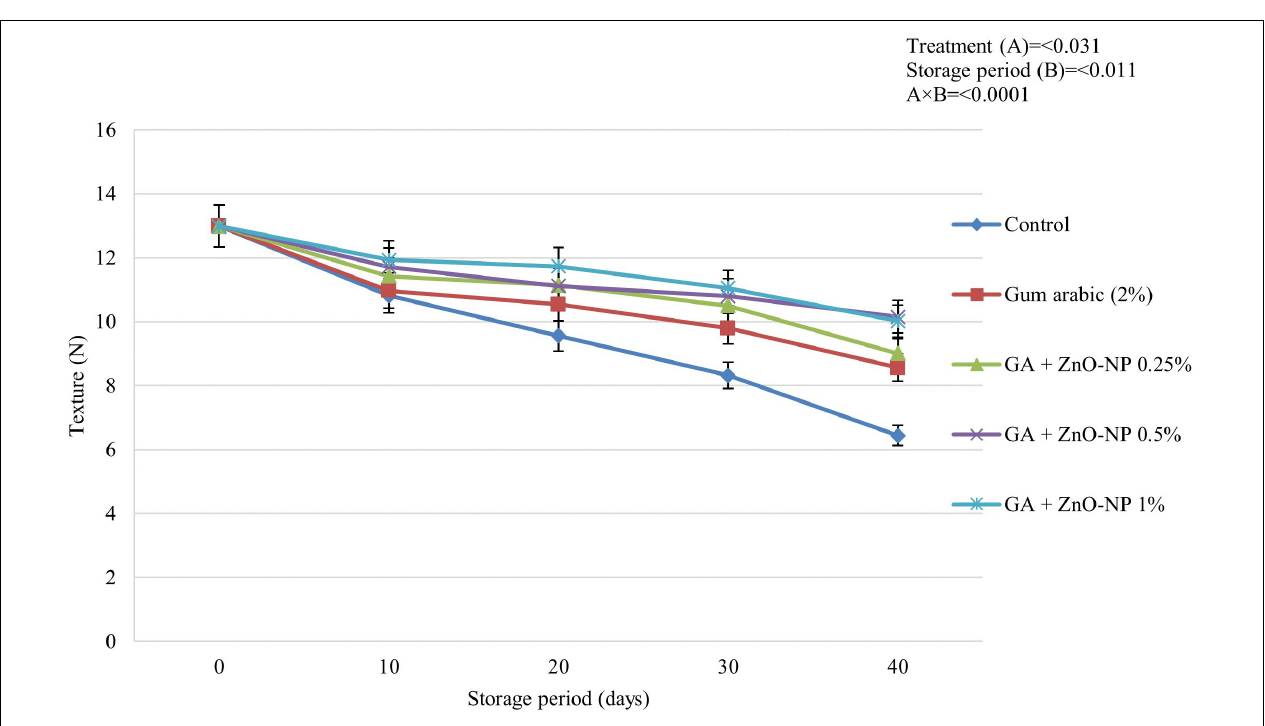
FIGURE 5 | The texture of ‘Kinnow’ mandarin fruit during storage for 40 days at 5 ± 1 ◦ C. Error bars denote the standard error (SE) of the mean. Means ± standard errors presented. To determine the interaction effects, factorial ANOVA was performed for the main factors, treatment, and storage time. GA + ZnO-NP, gum arabic + zinc oxide nanoparticles; N,